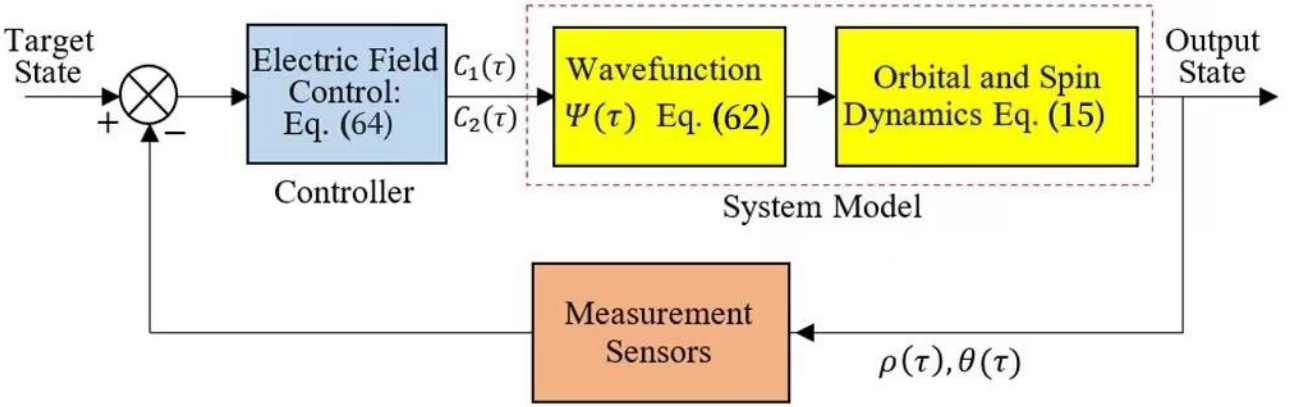
Figure 6. The control block-diagram representation of the two-level transition in hydrogen atom.